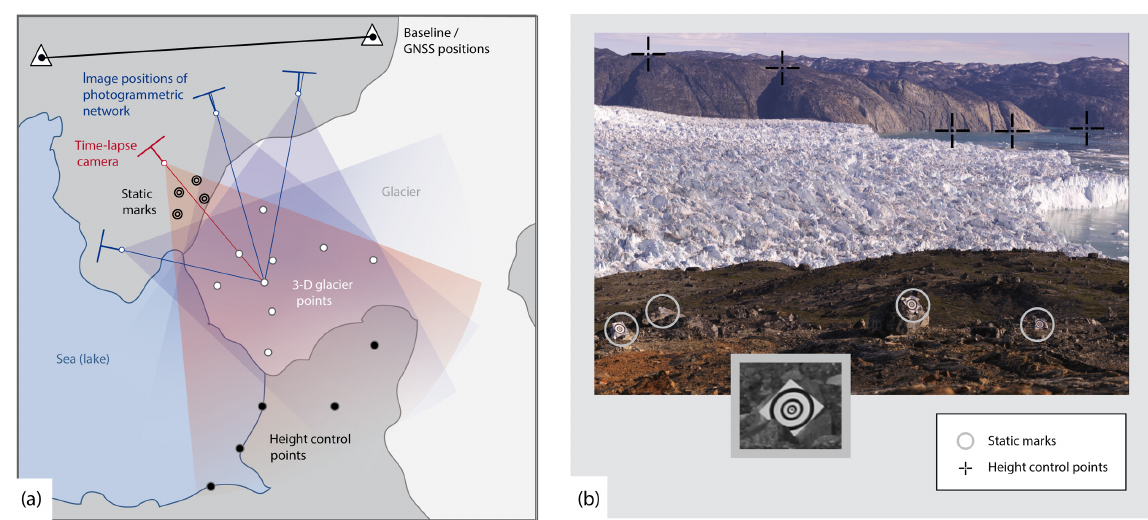
Figure 3. Combined scheme for the set-up of a time-lapse camera and its corresponding geo-referencing measurement set-up (a) ; measure- ment image of time-lapse camera (b)